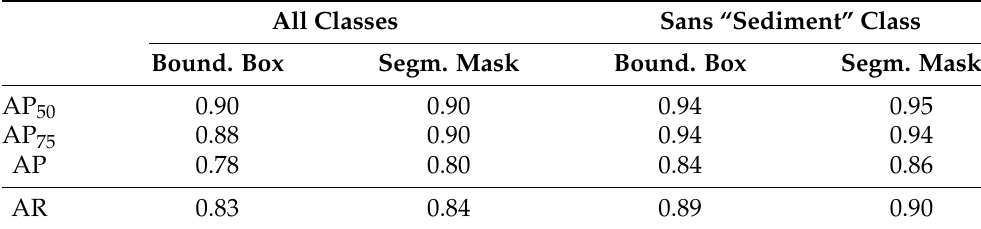
Table 2. AP and AR scores for different IoU thresholds, evaluated with all object classes being considered and with the “sediment” class